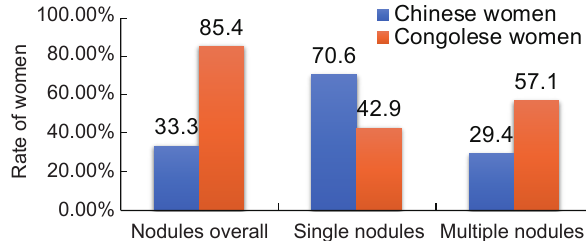
Figure 1 Distribution of women according to the effective of thyroid nodules within the thyroid gland